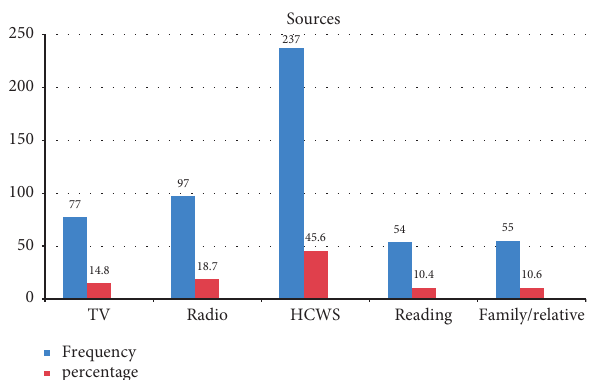
Table 2: Maternal obstetric related characteristics of mothers